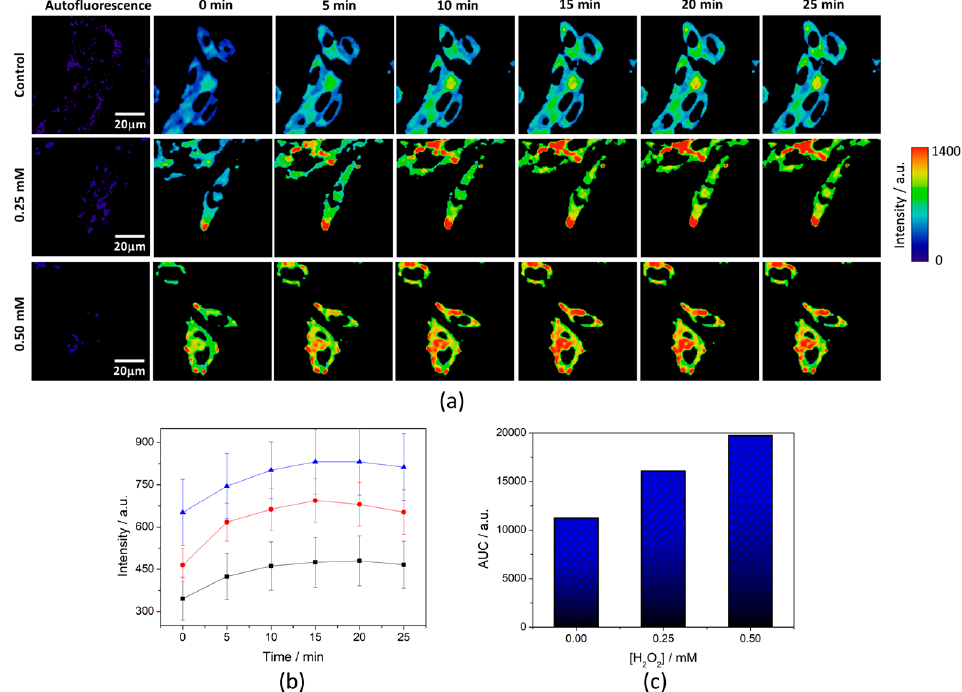
Figure 4. ( a ) Fluorescence intensity images of DNBS-2Me-4OMe-TM (6 × 10 − 7 M) in 661W cells after 12 h incubation with 0, 0.25, and 0.50 mM of H 2 O 2 , and ( b ) the corresponding emission intensity averaged over the pixels in the cytoplasm of at least four repeated experiments containing several cells (H 2 O 2 concentration: 0 mM, black; 0.25 mM, red; 0.50 mM, blue). Error bars represent the standard errors. ( c ) AUC values for the data are shown in panel ( b ).